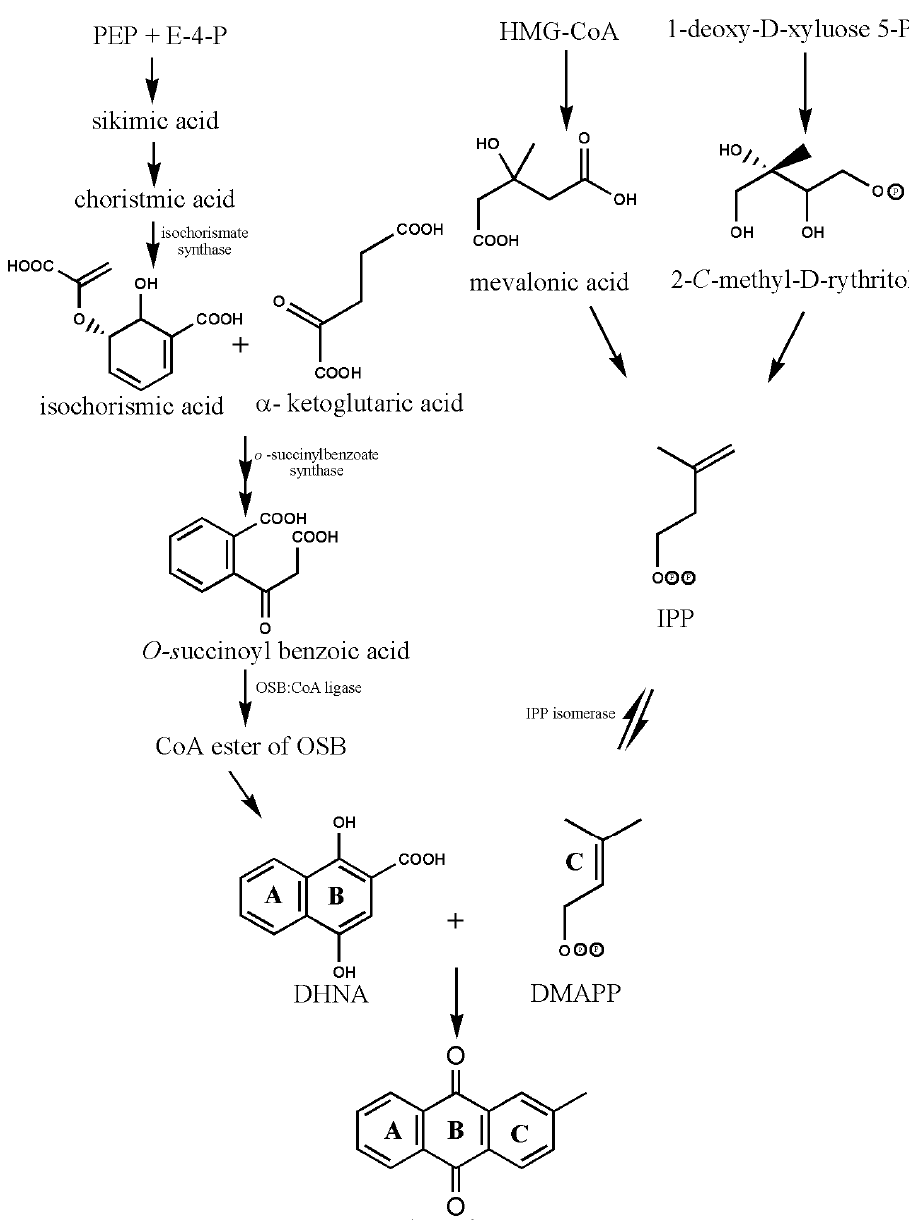
Figure 4. Biosynthesis of anthraquinones. PEP—Phosphoenolpyruvate; E-4-P—Erythrose-4-phosphate; OSB— o -succinylbenzoic acid, DHNA—1,4-dihydroxy-2-naphthoic acid, HMG-CoA—3-hydroxy-3-methylglutaryl coenzyme A, IPP—isopentenyl diphosphate, DMAPP—3,3-dimethylallyl